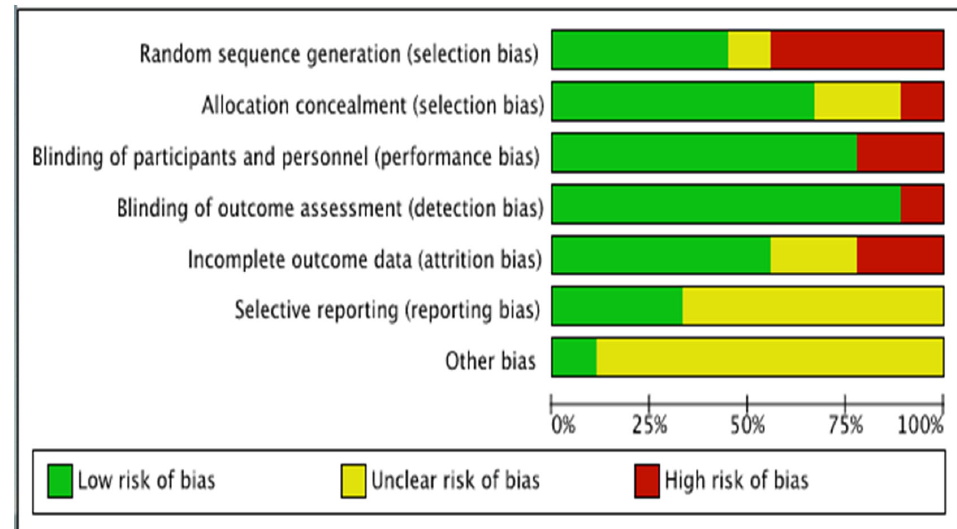
Figure 3. Risk-of-bias items are presented as percentages across all included studies.